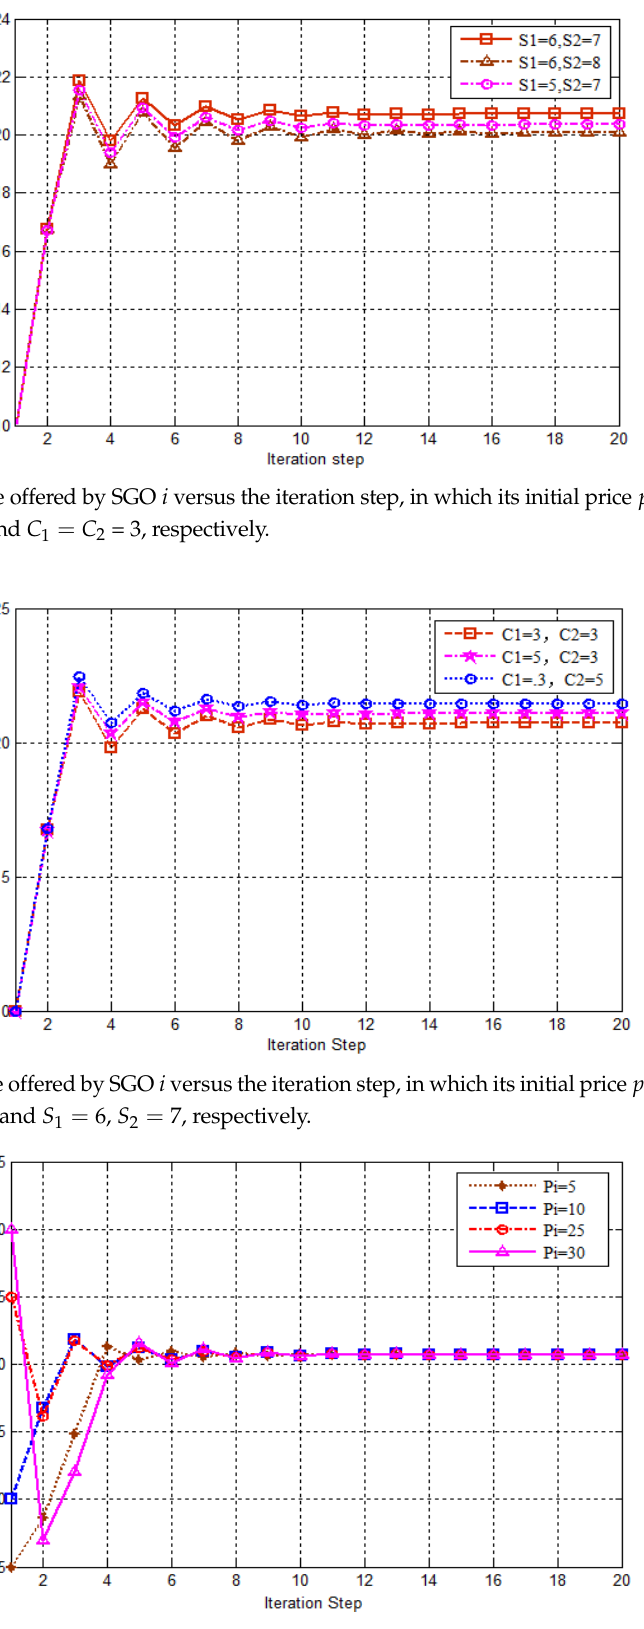
Figure 6. SGO’s price compared with the iteration step, given η 1 = 0.95, η 2 = 0.99, and C 1 = C 2 = 3, S 1 = 6, S 2 =